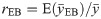
For the simulated population, bias index of the El-Badry estimator as a function of the nonresponse rate at the last phase, with varying values of πz.Curve of the bias index rEB=E(y¯EB)/y¯ based on 10 000 simulations of the nonresponse mechanism, for L = 3, πm(i) = 0.85 for 1 ≤ i < L, πm(L) = 0(0.1)0.9, and πz = 0(0.1)0.9 (black dots
πz = 0; white circles
πz = 0.1; black triangles down
πz = 0.2, white triangles up
πz = 0.3, black squares
πz = 0.4, white squares
πz = 0.5, black diamonds
πz = 0.6, white diamonds
πz = 0.7, black triangles up
πz = 0.8, white triangles down
πz = 0.9). Details in the text.